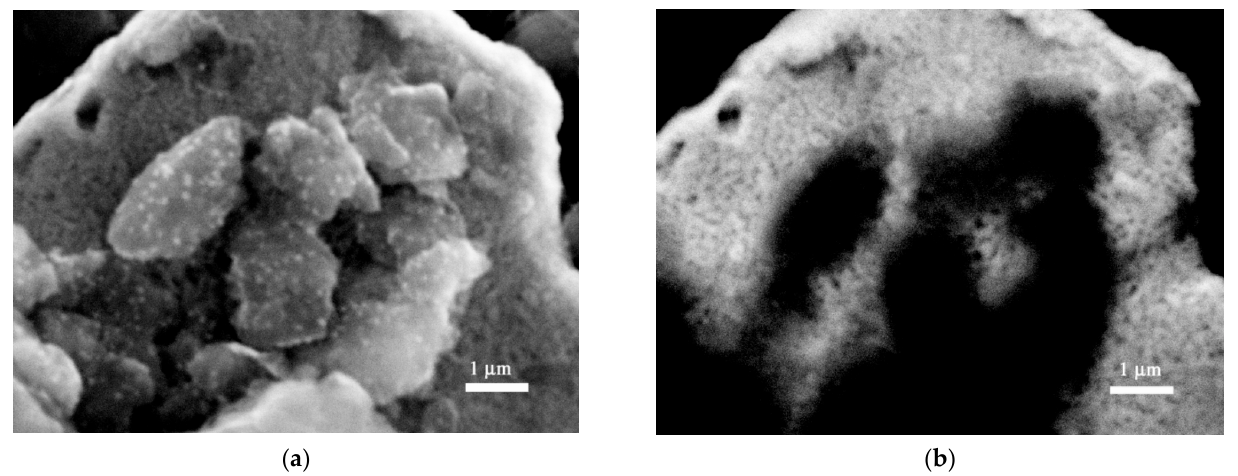
Figure 1. SEM image from the C–Cu mixture power. ( a ) SEM secondary electron image. ( b ) SEM backscattered-electron image.